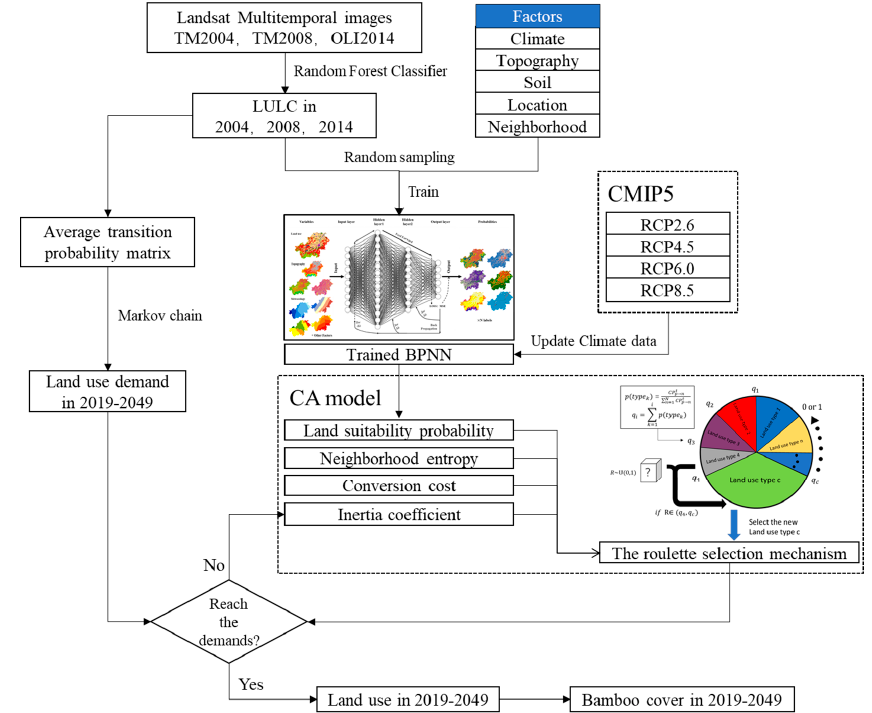
Figure 5. Flow chart for the simulation.